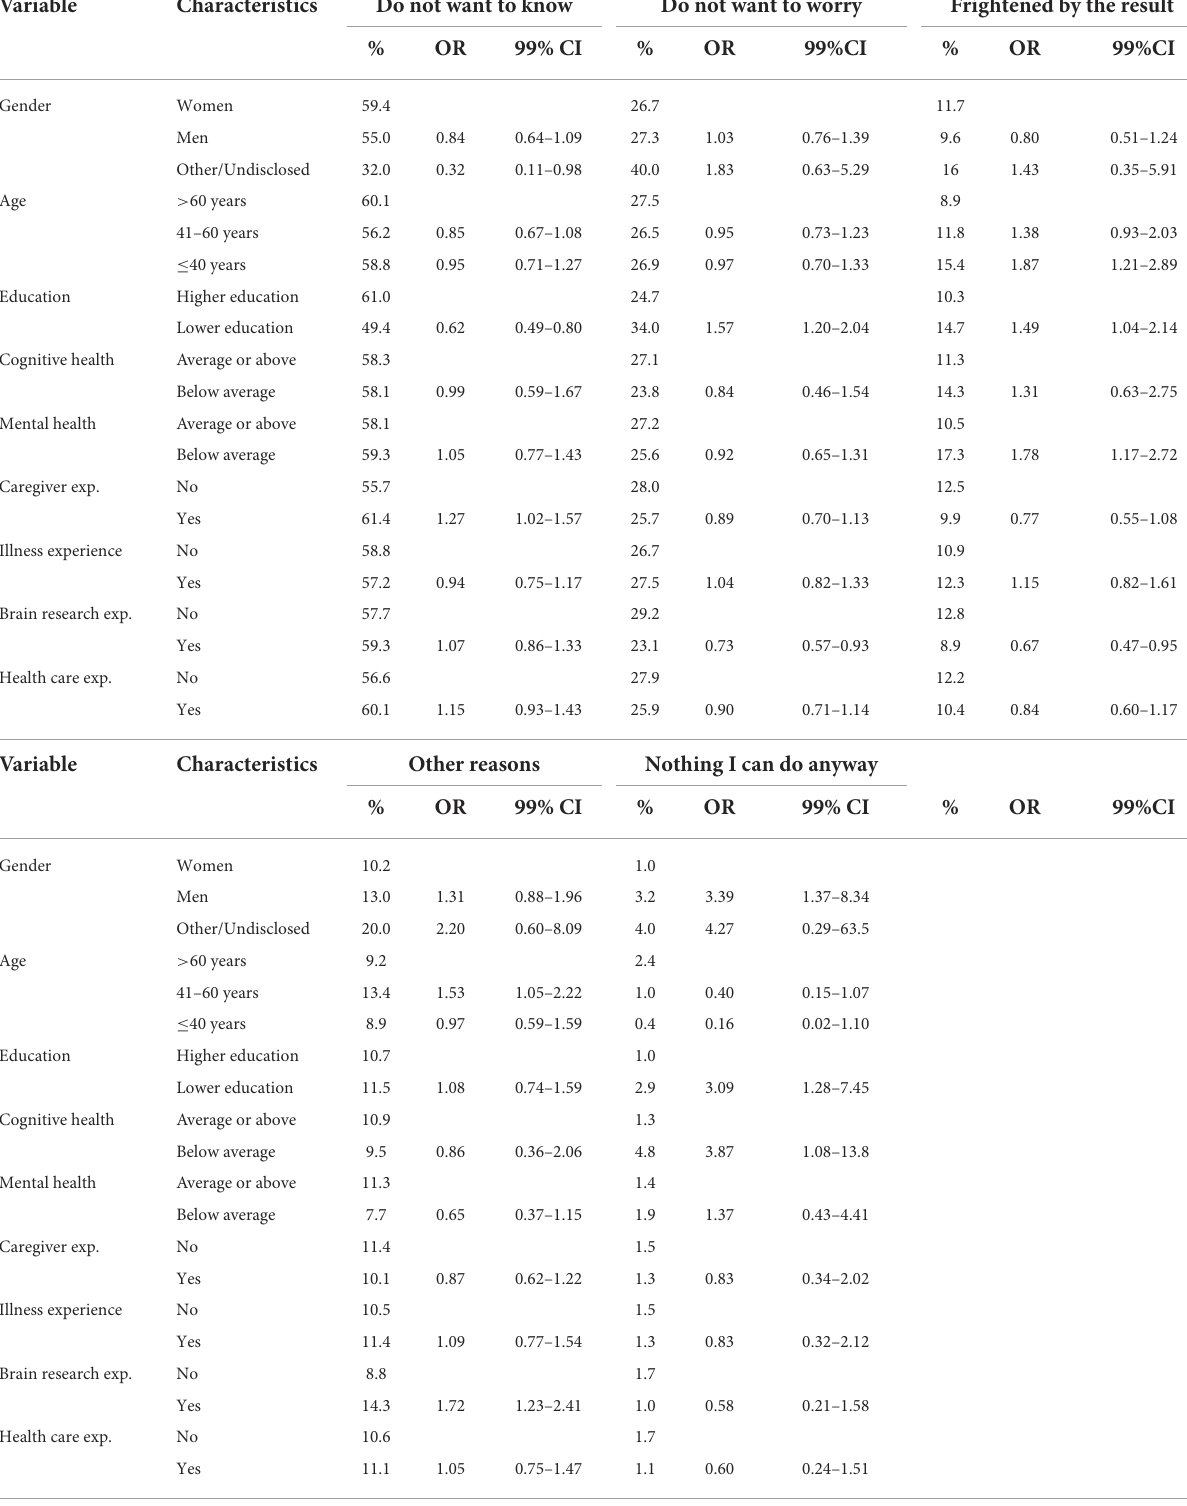
TABLE 3 Reasons for NOT wanting to take a brain health